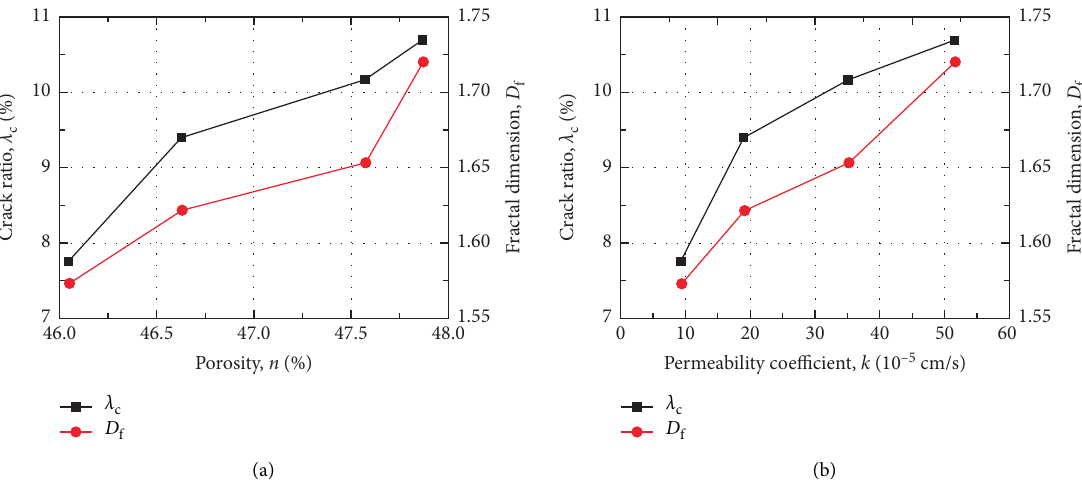
Figure 18: Correlations of quantified indexes of cracks with porosity and permeability coefficient. (a) Variation with porosity. (b) Variation with permeability